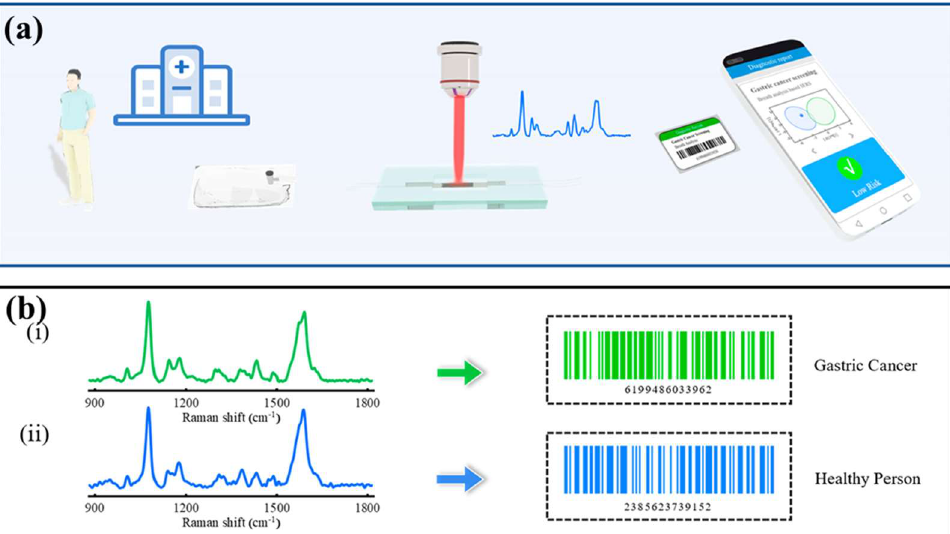
Figure 14. Breath analysis based on SERS sensor. ( a ) Schematic diagram of SERS sensor-based diagnostic workflow. ( b ) Typical SERS spectrum of breath sample obtained from (i) a gastric cancer patient and (ii) a healthy volunteer, and the barcodes were converted from the corresponding spectra (Reprinted with permission from Ref. [135]. Copyright 2022, American Chemical Society). Table 7. MOFs biosensors for biomedical applications.